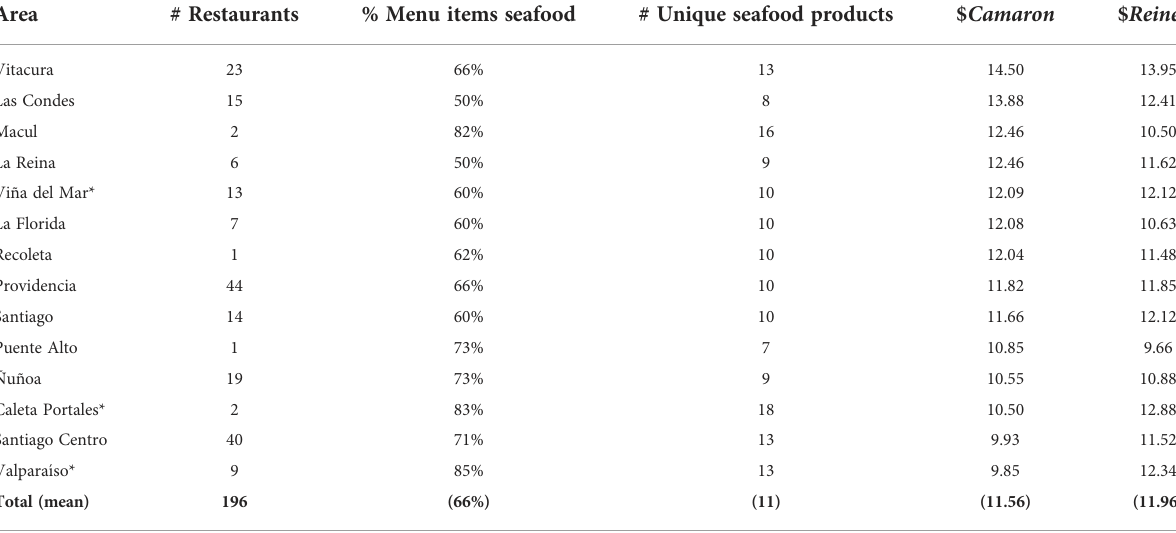
TABLE 2 Contextual characteristics of restaurants where interviews were conducted.